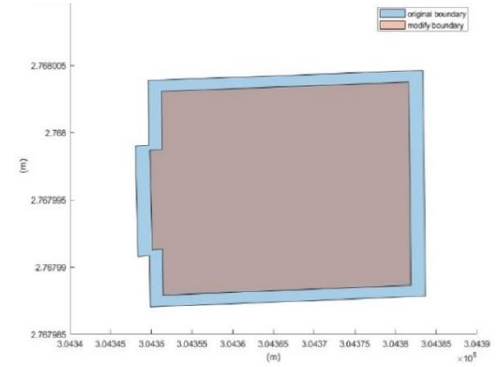
Figure 13. Example of building boundary homothetic transformation